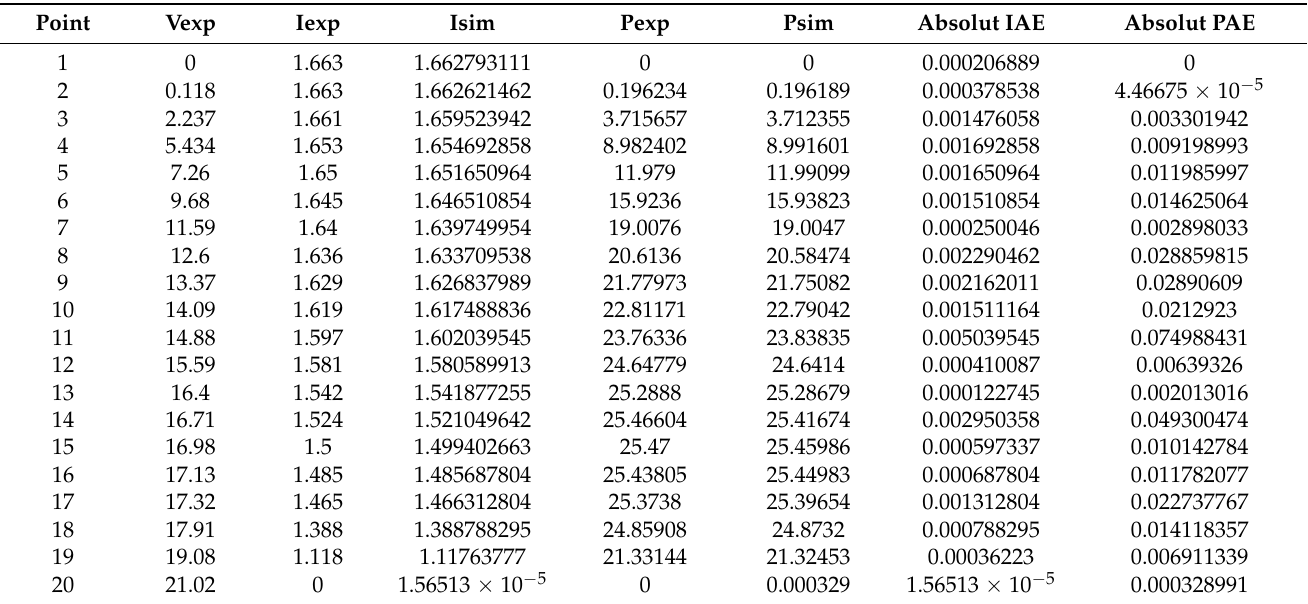
Figure 11. I–V and P–V characteristics of the proposed HPO for the triple-diode of STM6_40/36 PV module. Table 8. Simulated and experimental current and power and the absolute error established using the proposed HPO technique for TDM STM6-40/36 PV